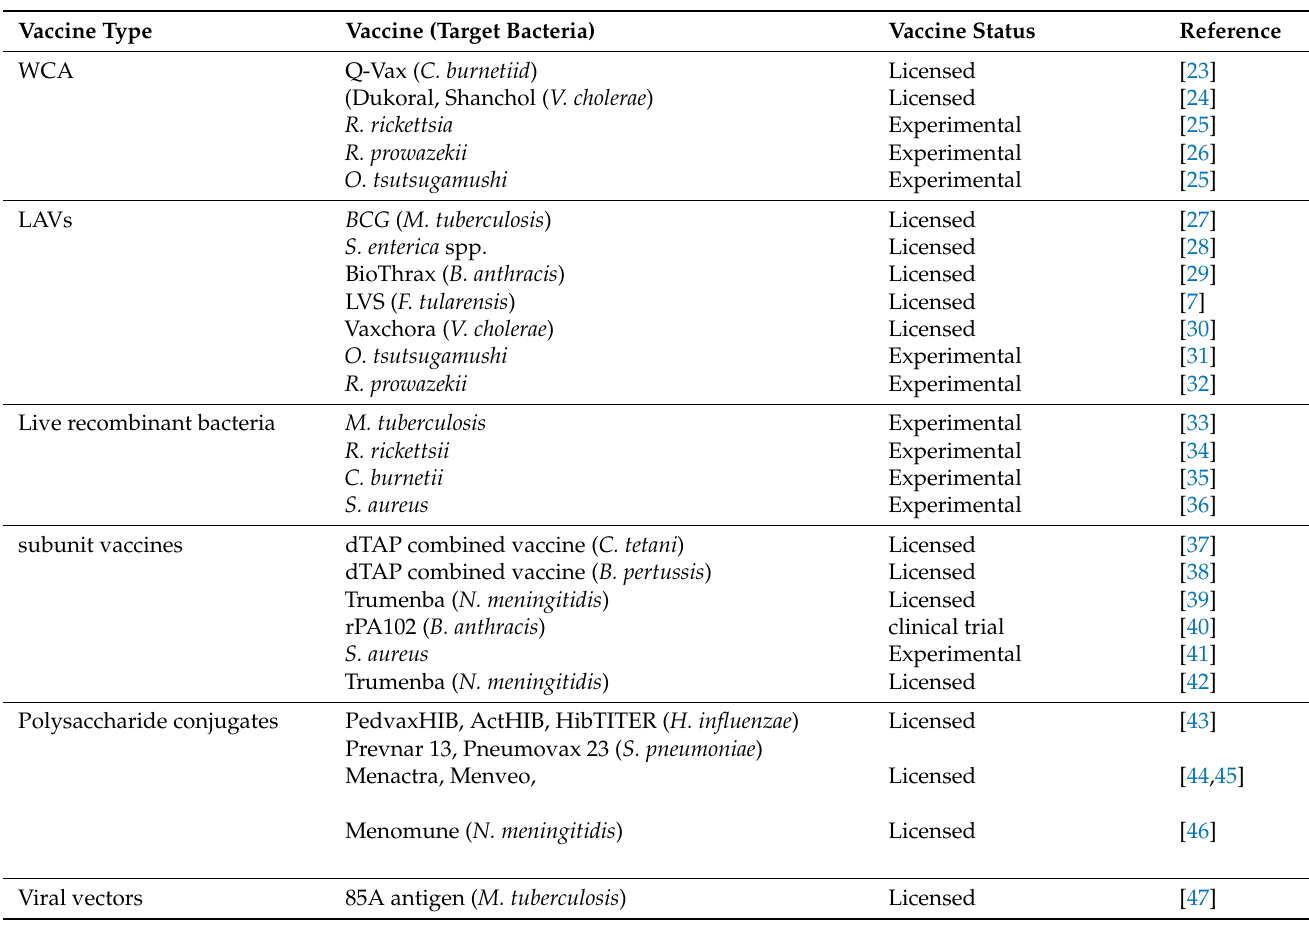
Table 2. Vaccine types for immunization against different bacterial infections (reprinted from Osterloh, 2022)